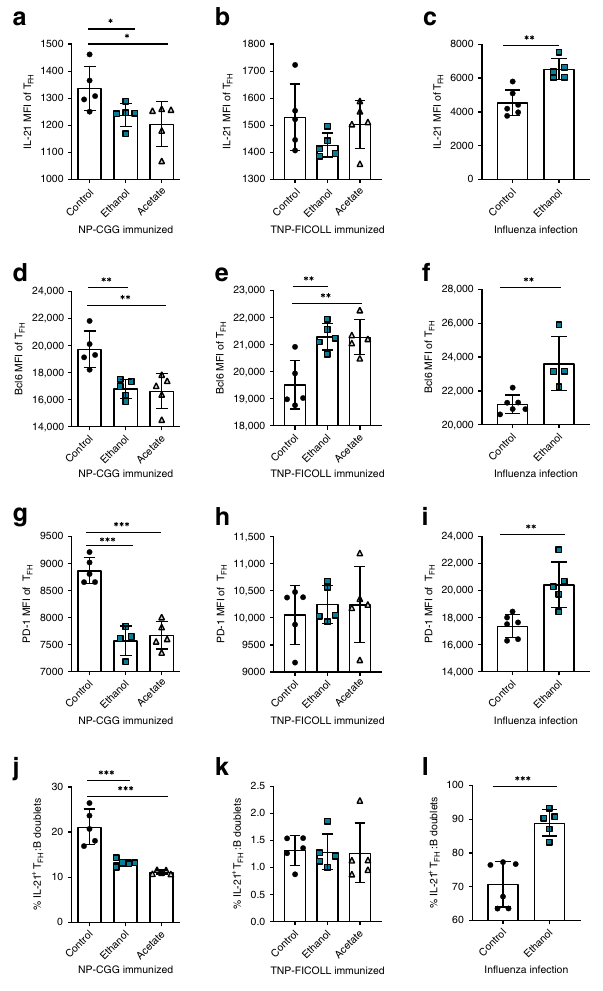
Fig. 7 Alcohol and acetate decrease IL-21, Bcl6 and PD-1 expression. a Flow cytometry analysis of IL-21 MFI of T FH cells in NP-CGG-, b TNP- FICOLL-immunized, c in fl uenza infected mice treated with water (control), ethanol, or acetate. d Flow cytometry analysis of Bcl6 MFI of T FH cells in NP-CGG-, e TNP-FICOLL-immunized, f in fl uenza infected mice treated with water (control), ethanol, or acetate. g Flow cytometry analysis of PD-1 MFI of T FH cells in NP-CGG-, h TNP-FICOLL-immunized, i in fl uenza infected mice treated with water (control), ethanol, or acetate. j Flow cytometry analysis of IL-21 producing T FH :B conjugates as percentage of all T FH :B cell conjugates in NP-CGG-, k TNP-FICOLL-immunized, l in fl uenza infected mice treated with water (control), ethanol, or acetate. a , b , d , e , g , h , j , k n = 5 mice per group per experiment and representative experiment of three independent experiments shown. c , f , i , l n = 6 mice per group per experiment and representative experiment of two independent experiments shown. Data are expressed as mean ± SD. Statistical difference was determined by one-way ANOVA ( a , b , d , e , g , h , j , k ) or Students two-tailed t -test ( c , f , i , l ). * p < 0.05; ** p < 0.01; *** p <